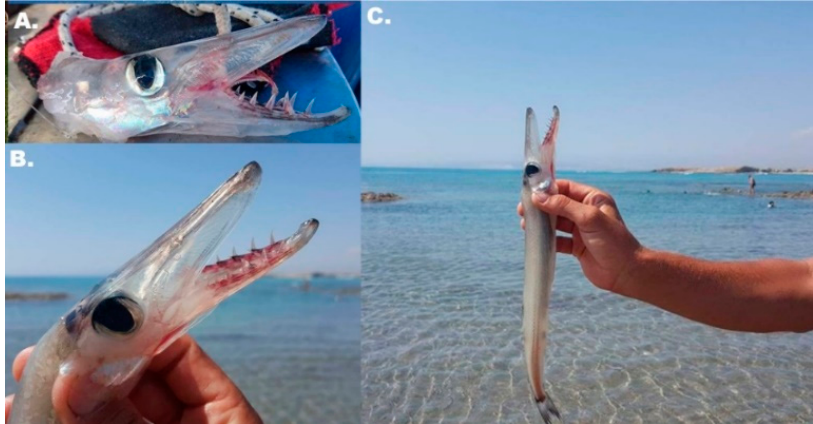
Figure 3. ( A ): Head of Sudis hyalina collected from demersal longlines off Kastellorizo Island, Greece; ( B ) individual captured in Akrotiri Bay, Cyprus; and, ( C ): individual captured in Chalkidiki Peninsula, Greece.